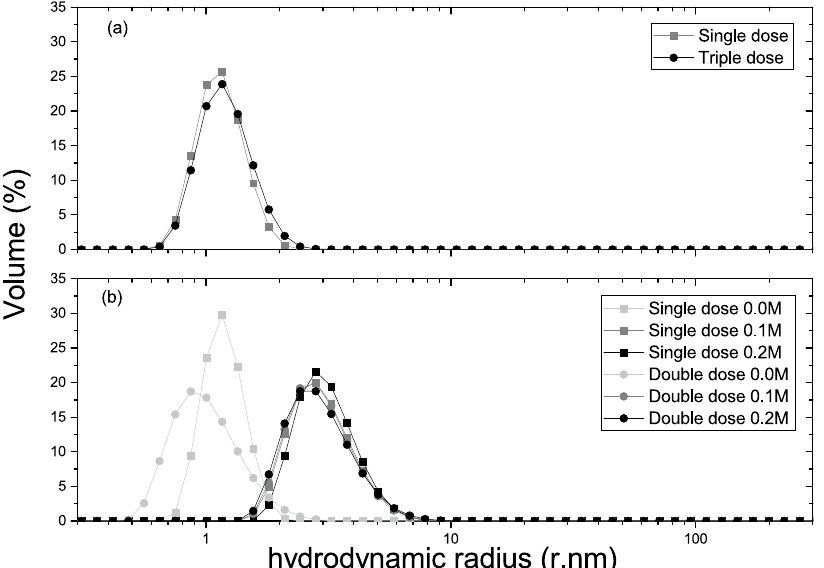
Figure 1. Volume (%) against hydrodynamic radius of insulin obtained from dynamic light scattering of ( a ) Insulin glargine (single and triple dose) and ( b ) Insulin degludec (single and double dose at 0.0, 0.1 and 0.2 M ionic